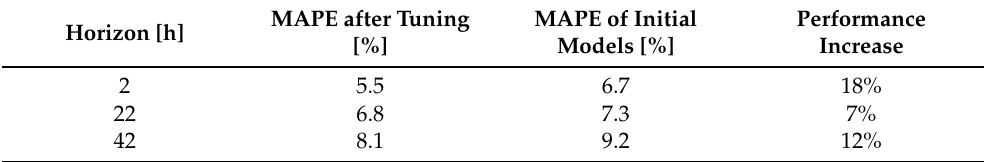
Table 2. Average performance of best FFNN test models after architecture tuning compared with the performance of the initial models from Section